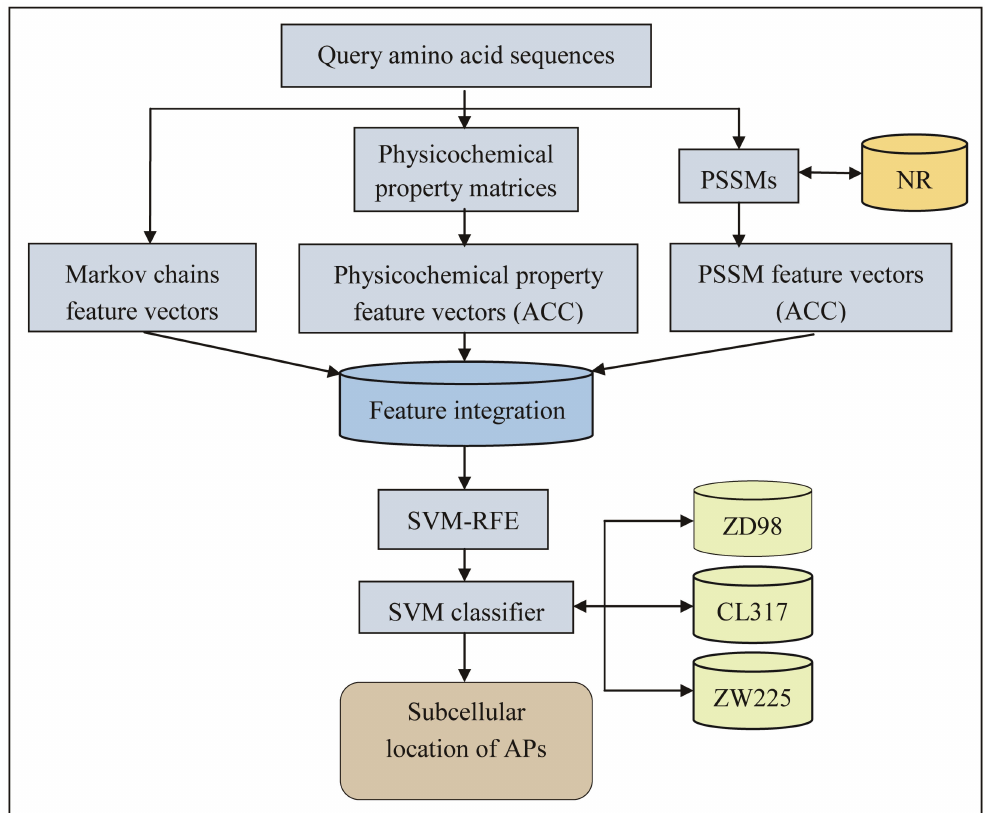
Figure 1. The flowchart of the iAPSL-IF method. NR: non-redundant (NR) database of the National Center for Biotechnology Information (NCBI) (available online: